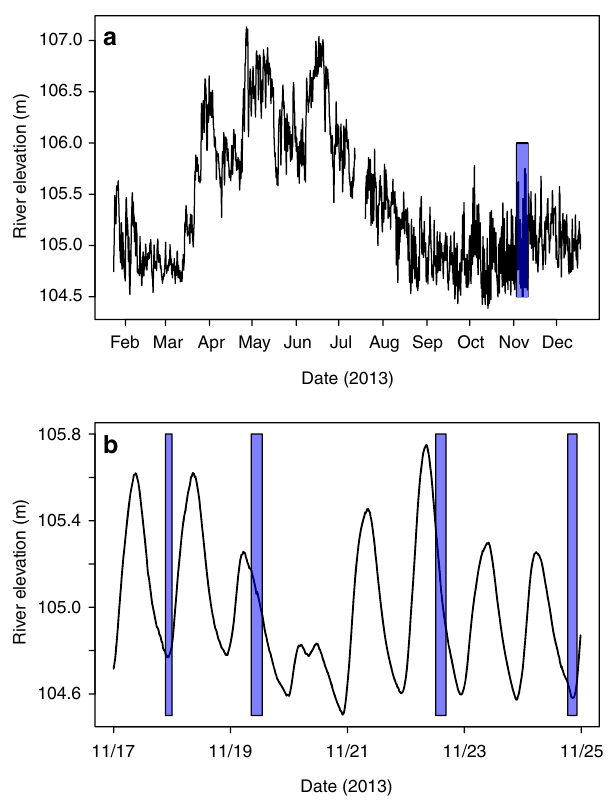
Figure 2 | Stage dynamics of the Columbia River and sampling intervals. ( a ) River stage dynamics across 2013 with the date range of sampling indicated by the overlaid rectangle. ( b ) River stage dynamics during the sampling period with hourly ranges of sampling indicated by the overlaid